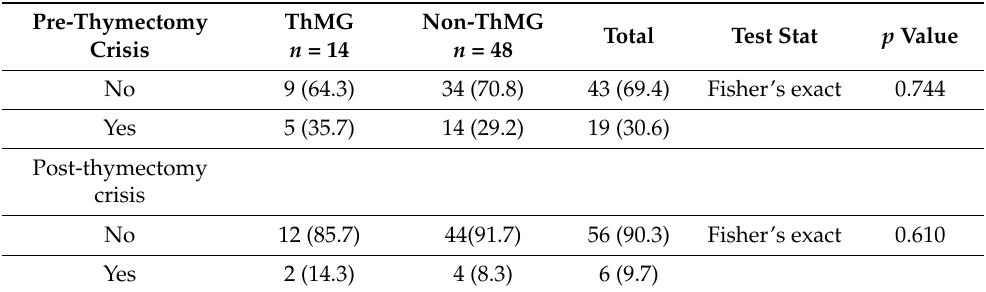
Table 7. Comparison of the frequencies of MG crises pre- and post-thymectomy between ThMG and non-ThMG